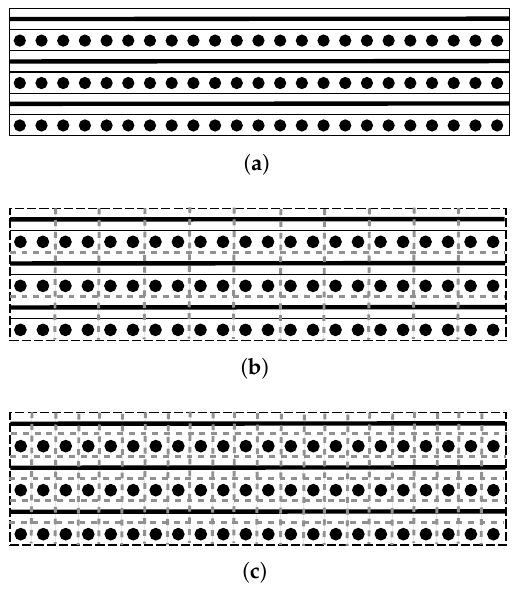
Figure 5. Example for a 6 layer layup ( a ), where the dashed gray lines indicate the cells of a coarse mesh ( b ) and of a fine mesh ( c ).